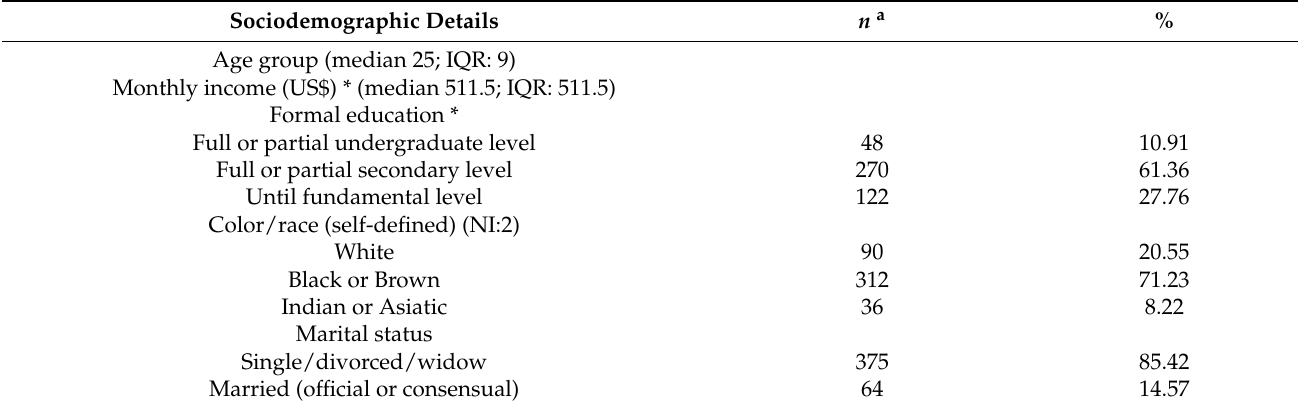
Table 1. Characteristics of 440 transgender women in Central